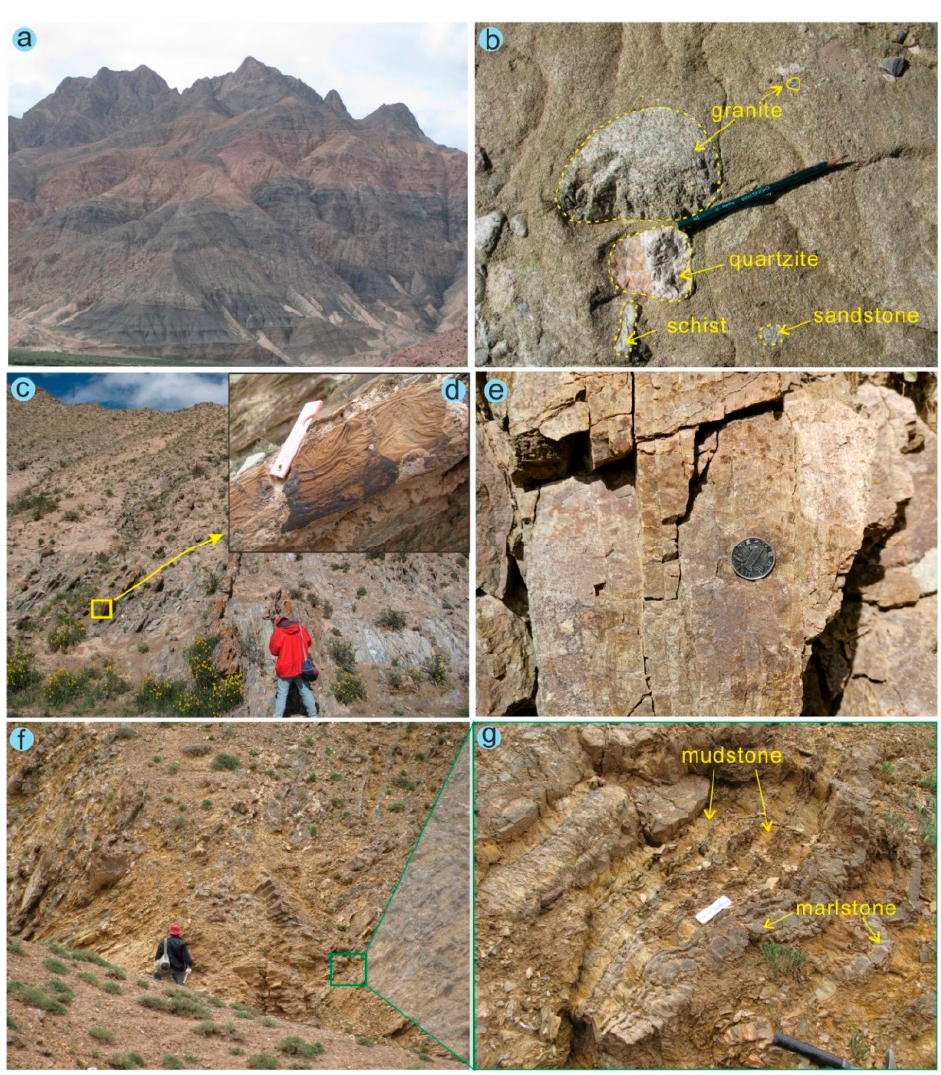
Figure 15. Field photographs showing the sedimentary characteristics of Late Permian–Middle Triassic Hongshuichuan forearc basin: ( a ) the fan-delta deposition of the lower part of the Hongshuichuan Formation; ( b ) pebbly feldspathic sandstone from the Hongshuichuan Formation showing pebbles of granite, quartzite, schist in a matrix of medium-grained sandstone; ( c ) rhythmically bedded sandstone, siltstone, and minor mudstone turbidite units with a variable thickness of 10–60 cm; ( d ) soft-sediment deformation showing convolute bedding in turbidite; ( e ) light colored rhyolite occurs as intercalations in Hongshuichuan Formation (taken in Zhanhongshan area). Naocangjiangou Formation: ( f ) rhythmic alternations of mudstone and marlstone with a variable thickness of 5–40 cm; ( g ) thin limestones interlayered with minor mudstones.